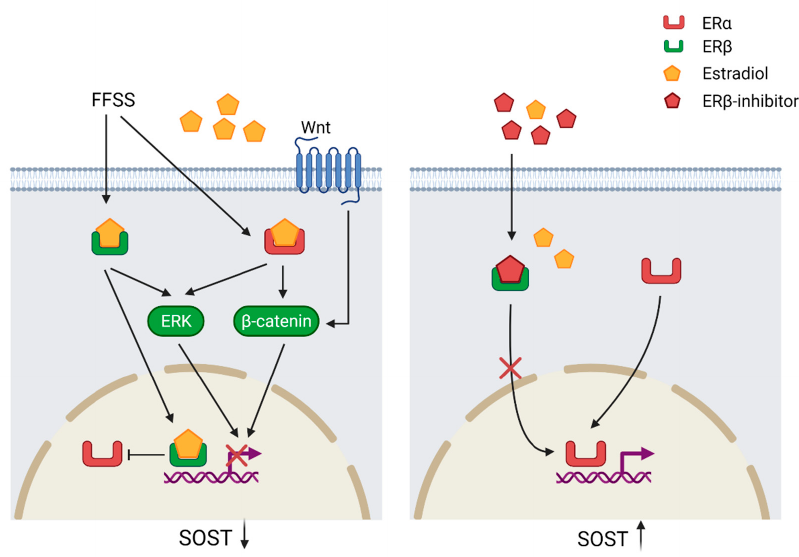
Figure 3. Regulation of SOST through the estrogen receptor (ER) pathway. Fluid flow shear stress (FFSS) and estradiol (E2) binding to ER β suppresses ER α binding to the regulatory motif of SOST resulting in SOST down-regulation. Estradiol binding to the ERs triggers the extracellular signal- regulated kinase (ERK) and Wnt/ β -catenin, which suppress SOST expression. The ER α ligand independently maintains basal SOST expression and Er β inhibition prevents down-regulation of SOST . SOST downregulation = black arrow down; SOST upregulation = black arrow up. Created with BioRender.com, accessed on 15 February